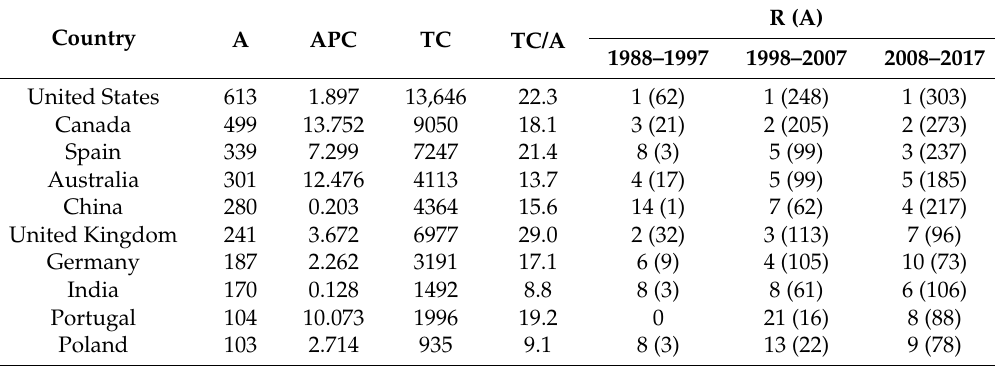
Table 3. Most productive countries in MW research.